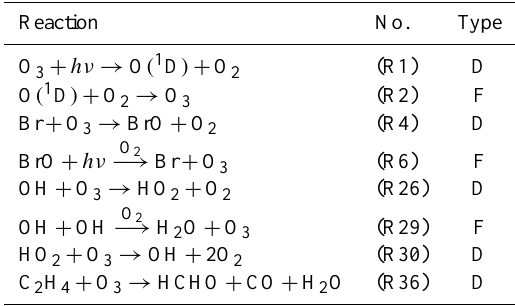
Table 3. List of ozone-relevant reactions (type F: ozone formation; type D: ozone